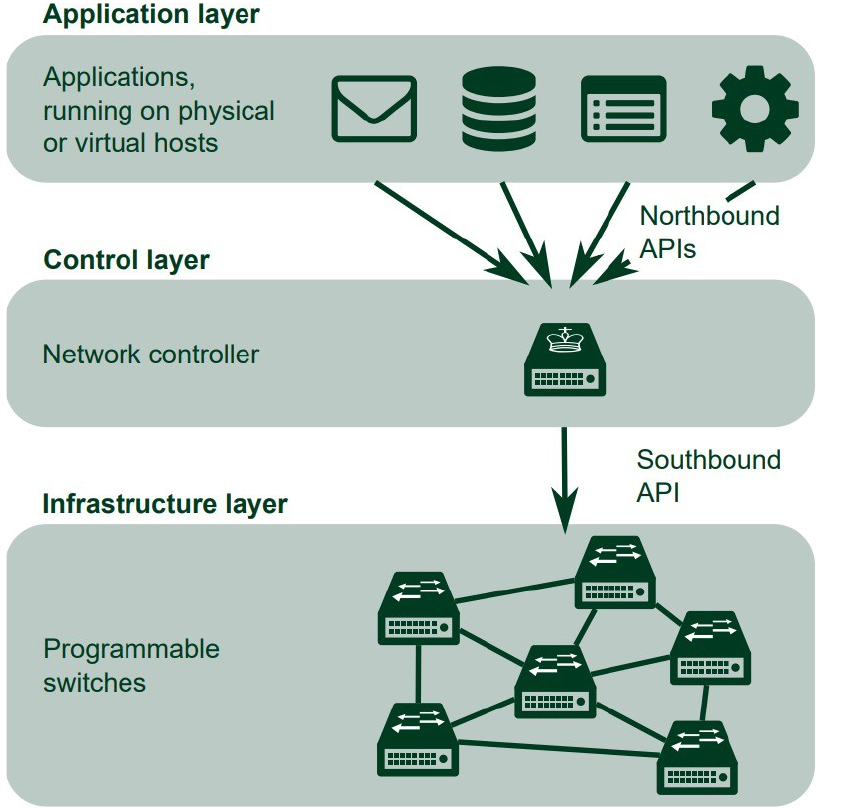
Figure 4. SDN architecture